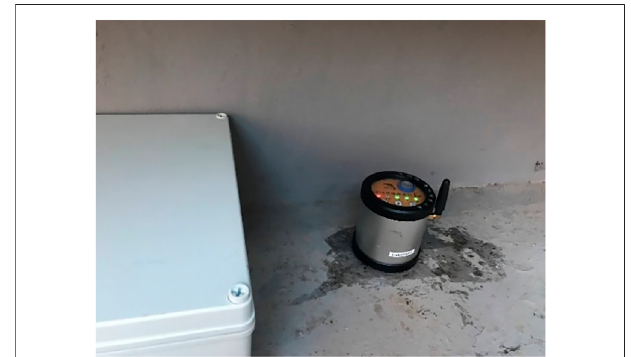
FIGURE 17 | The TC-6850 vibrometer.